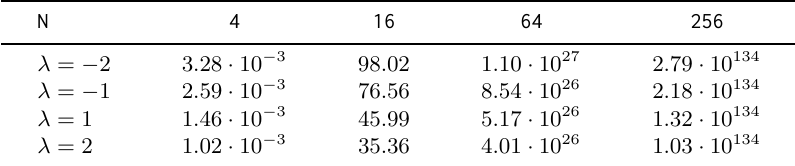
y ( s ) ds + f ( t ) , step-by-step method. 0